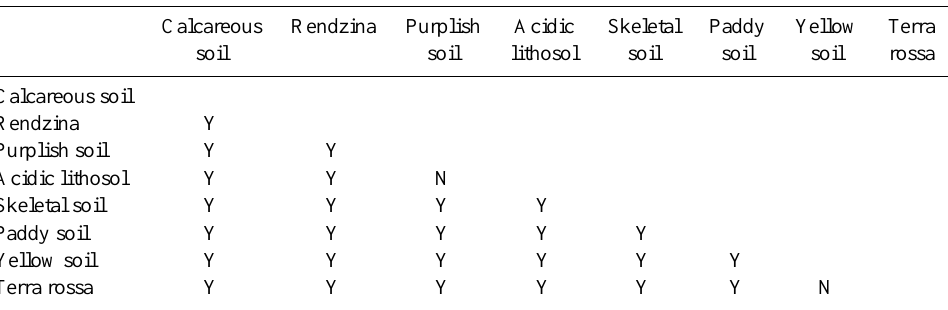
Paddy soil Yellow